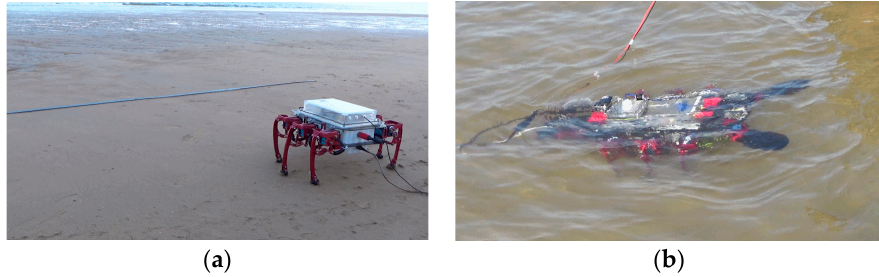
Figure 12. The walking experiment in a real amphibious environment by the sea. ( a ) is the experi-